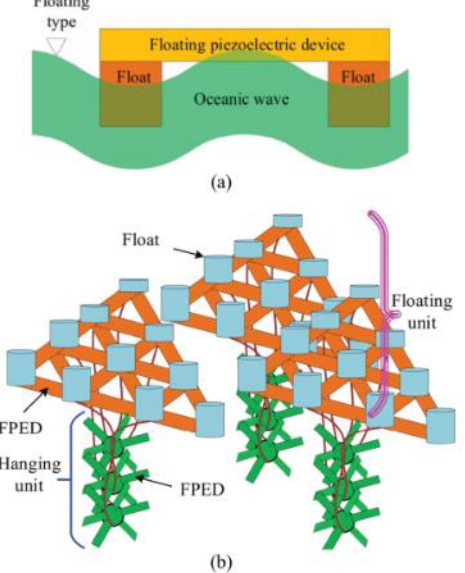
Figure 16. Elastic floating unit with hanging structure: ( a ) single device; ( b ) aggregated structure.